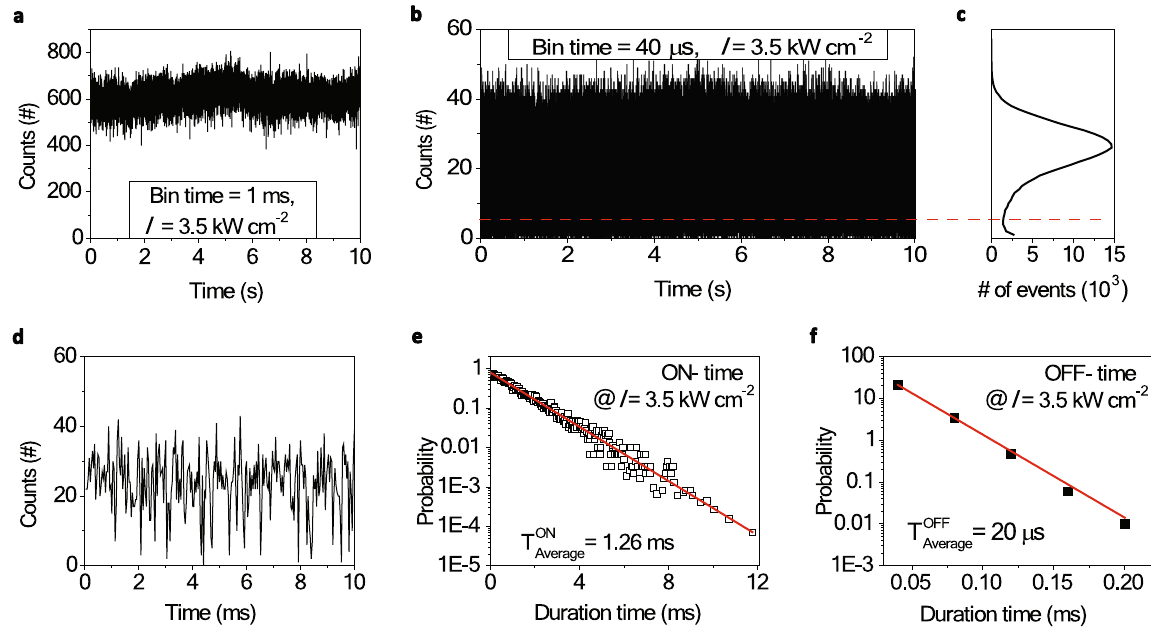
Figure 2. Blinking study by the PL intensity trajectory. ( a ) PL intensity trajectory of a single emitter with a time bin size of 1 ms. ( b ) The same data in ( a ) but with a smaller time bin size of 40 μ s. ( c ) Histogram of the photon count events of the time trajectory in ( b ). ( d ) A zoomed in intensity trajectory of ( b ). Probability distributions of ( e ) “ON” and ( f ) “OFF” time durations presented in semi-log scale. Single exponential fittings (red lines) are